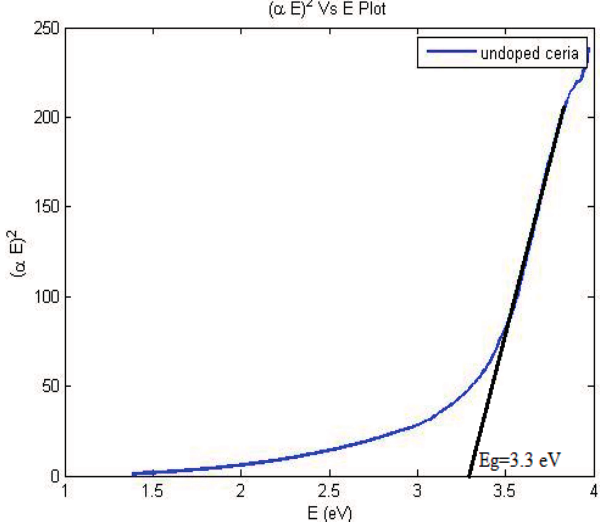
Figure 4. Bandgap calculations of the synthesized ceria nanoparticles.